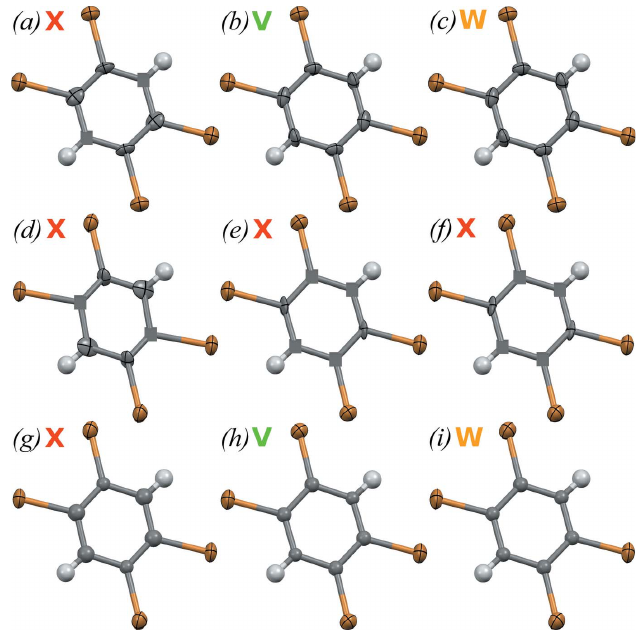
Figure 2 Displacement ellipsoid plots for 1,2,4,5-tetrabromobenzene molecules obtained with different data-treatment procedures. Carbon atoms for structure refinements ( g ), ( h ) and ( i ) were refined using an isotropic approximation. Cubes show atoms with negative thermal parameters. Refinements marked V are preferable for publication; those marked W are publishable but not always preferable, and those marked X are not acceptable for publication